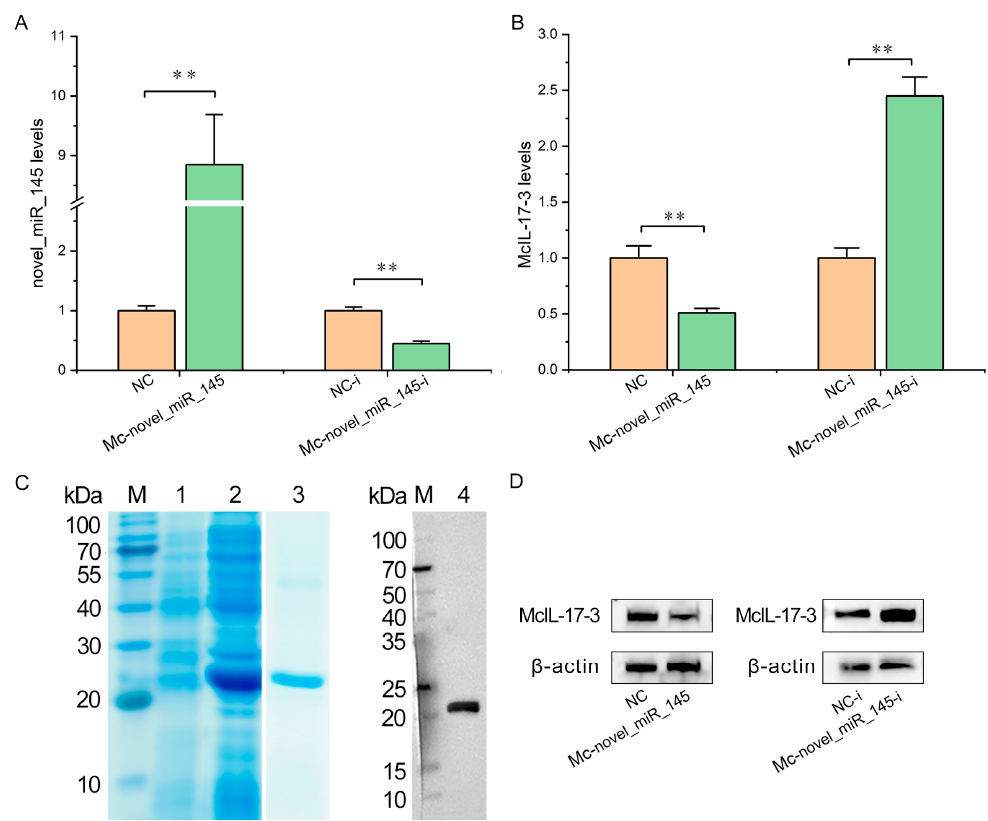
Figure 6. Mc -novel_miR_145 inhibited the expression of Mc IL-17-3 in M. coruscus hemocytes. ( A ) The expression of Mc -novel_miR_145 was assessed by qPCR in hemocytes transfected with 145 mimic, 145 inhibitor and their respective control. ( B ) After transfection for 24 h, the transcriptional levels of Mc IL-17-3 were determined by qPCR. ( C ) Recombinant expression, purification, and the antiserum preparation for Mc IL-17-3. Lane M, standard protein molecular weight marker. Lane 1, negative control (without induction). Lane 2, induced recombinant protein Mc IL-17-3. Lane 3, purified Mc IL-17-3. Lane 4, Western blot with anti- Mc IL-17-3 antibody in the hemocytes of M. coruscus . ( D ) After transfection for 24 h, the protein levels of Mc IL-17-3 were determined by Western blot. * p < 0.05 and ** p < 0.01 versus the controls.